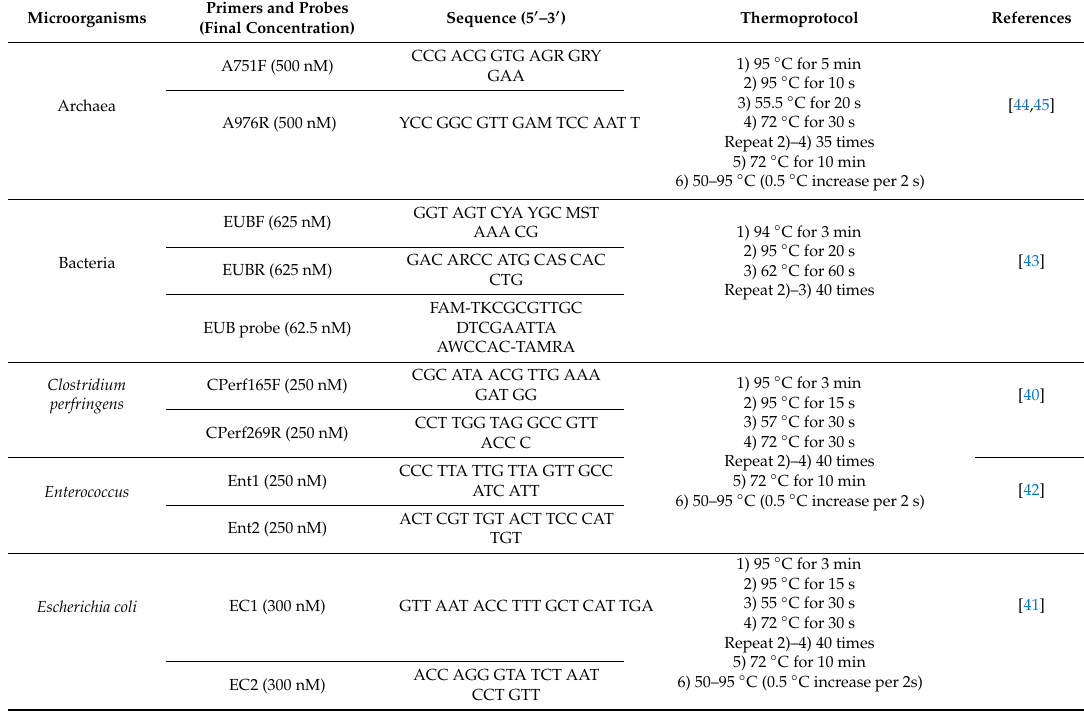
Table 1. qPCR protocols for targeted